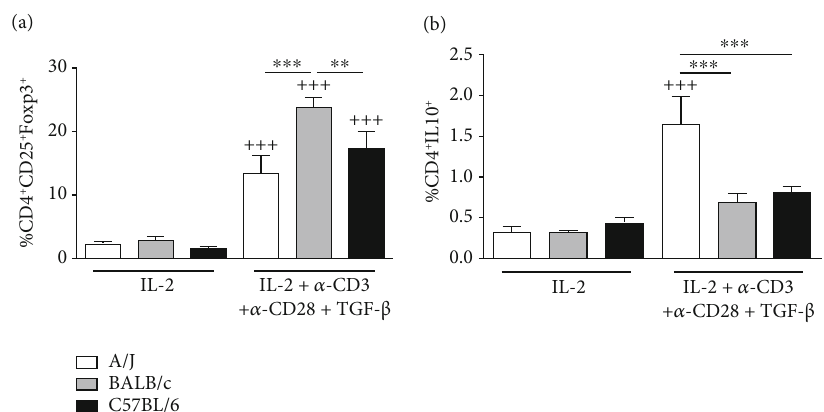
Figure 5: In vitro expansion of CD4 + CD25 + Foxp3 + and CD4 + IL10 + cell populations from lymph nodes of A/J, BALB/c, or C57BL/6 naive mice. Cells from cervical, axillary, and inguinal lymph nodes were cultured for 72h in the presence of IL-2 or IL-2 +TGF- β +anti-CD3 +anti-CD28, and subpopulations of CD4 + CD25 + Foxp3 + (a) or CD4 + IL-10 + (b) were analyzed by fl ow cytometry. Values represent mean ± SEM of 4-5 animals per group. +++ P < 0 : 001 as compared to the same mouse strain cells that received only IL-2. ∗∗ P < 0 : 01 and ∗∗∗ P < 0 : 001 are comparisons of di ff erent mouse strains stimulated with IL-2 +TGF- β